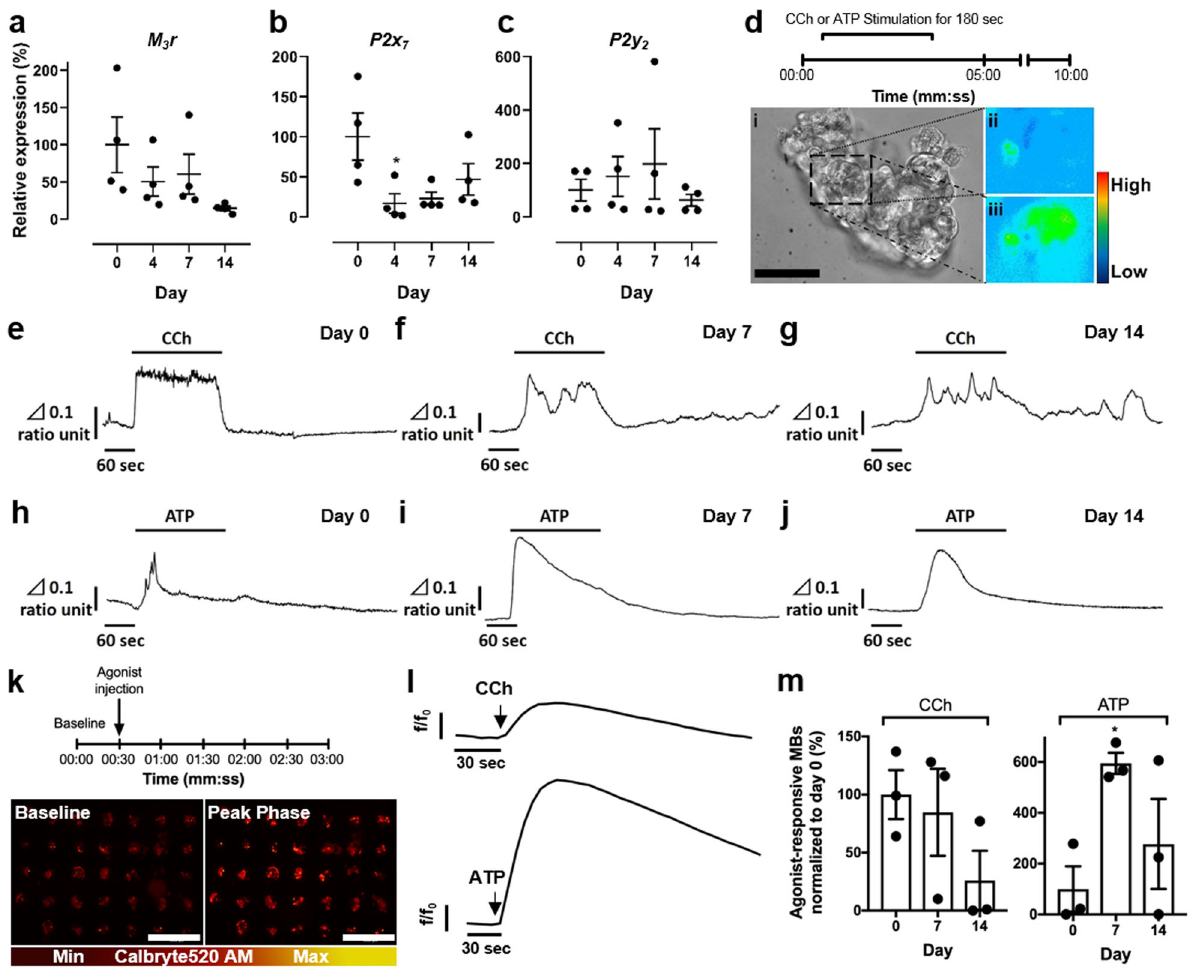
Fig. 4 Mouse SGm in MB-hydrogels are responsive to stimulation with muscarinic agonist carbachol (CCh) and purinergic agonist ATP. a – c Gene expression pro fi les of muscarinic receptor type 3 ( M 3 r: a ) and purinergic receptors ( P2x 7 : b and P2y 2 : c ) in freshly isolated mouse salivary gland tissue and SGm at days 4, 7, and 14. d Experimental time-course of calcium imaging on mouse SGm using Fura-2 AM: fl uorescent imaging was initiated at time 0 with continuous perfusion of buffer. CCh was then perfused for 180 s. After perfusion of buffer for 10 min, ATP was perfused for 180 s. Images of SGm at day 7: bright fi eld ( d : i); baseline fl uorescent intensity of [Ca 2 + ] i ( d : ii) and peak phase fl uorescence of [Ca 2 + ] i after stimulation with CCh ( d : iii). Pseudocolor bar indicates relative intensity of Δ 340/380 ratio. Δ 0.1 ratio unit equals 340/380 ratio = 0.1. Scale bar = 50 μ m. e – g CCh stimulation leads to an elevation of [Ca 2 + ] i at day 0 ( e ) and in SGm (day 7: f , day 14: g ). h – j Changes in [Ca 2 + ] i in AIDUCs ( h ) and in SGm (at day 7: i , day 14: j ) are generated by stimulation with ATP. Vertical bar shows Δ 340/380 ratio unit, and horizontal bar indicates time unit. k – m Ca 2 + signaling assay of SGm in whole tissue chips. k Experimental timeline of fl uorescent imaging of Ca 2 + -binding indicator Calbryte520 AM: baseline signals were collected in buffer from time 0, and CCh or ATP were injected at 30 s. l Representative fl uorescent traces of responsive SGm at day 7 upon CCh and ATP stimulation. Data are represented as fl uorescent intensity ( f ) divided by fl uorescence at time 0 ( f o ). m Percent of SGm in MBs responsive to CCh and ATP. Response is characterized by a signi fi cant difference between baseline timepoints and agonist timepoints via unpaired t -tests corrected for multiple comparisons using Holm – Sidak with α = 0.05. Data is graphed and normalized to day 0 as 100%. Data showed mean ± SEM, N ≥ 3, n = 85 – 97 per timepoint. ** p < 0.01, * p <